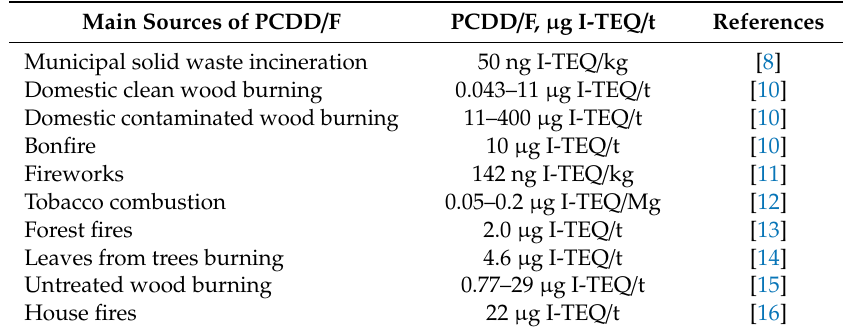
Main sources of polychlorinated dibenzofurans (PCDD / F) contamination and their emission